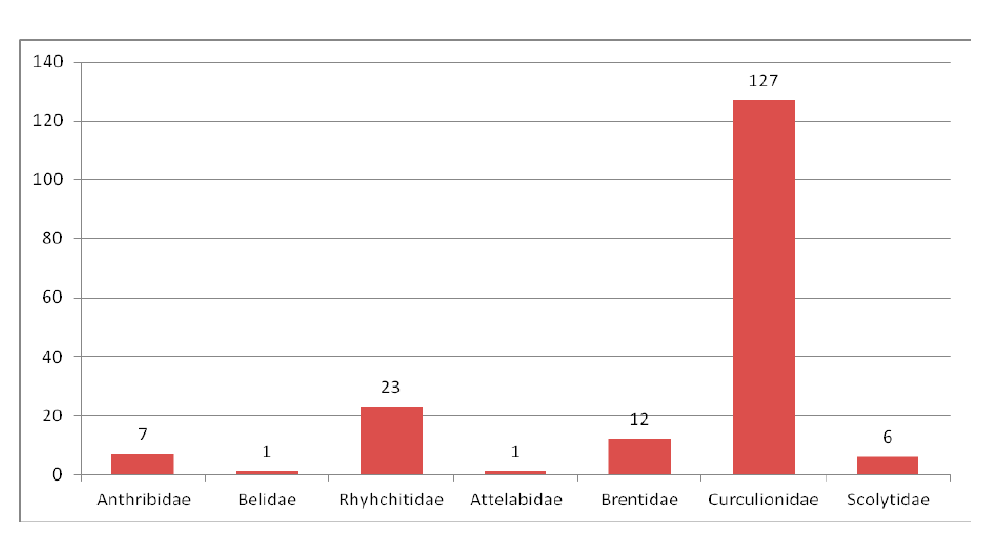
Figure 16. Composition of species of Curculionidae in the Florissant. Geosciences 2019 , 9 , x FOR PEER REVIEW